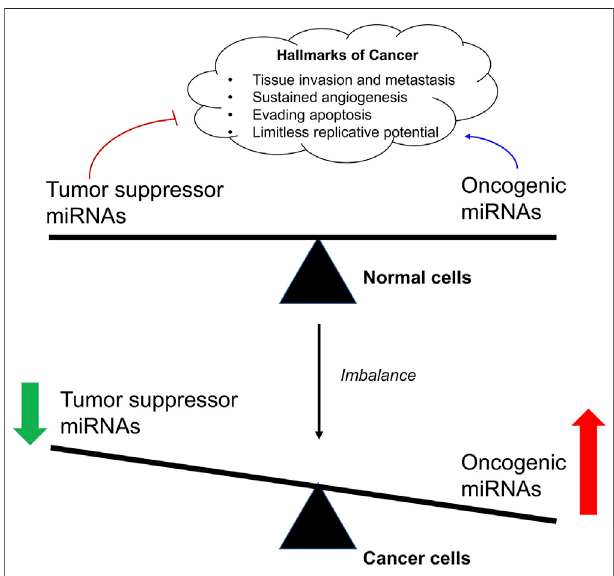
FIGURE 2 | The roles of oncogenic miRNAs aand tumor suppressor